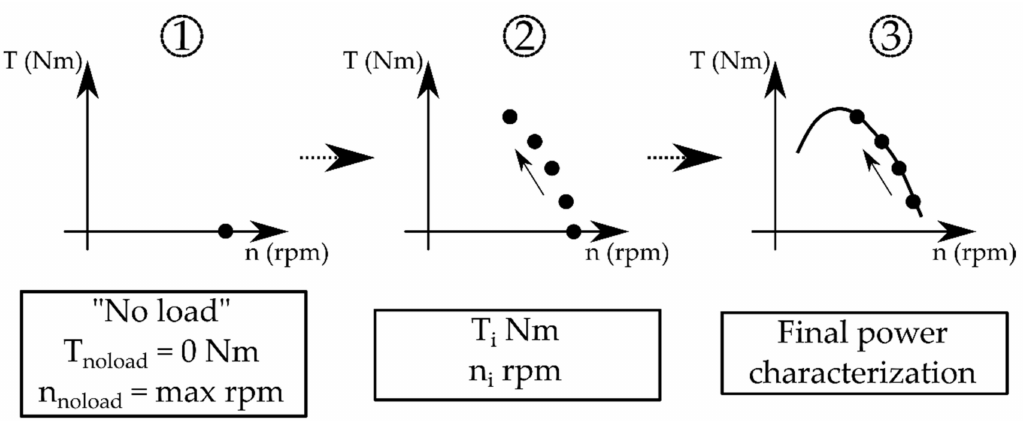
Figure 6. Scheme of the experimental characterization